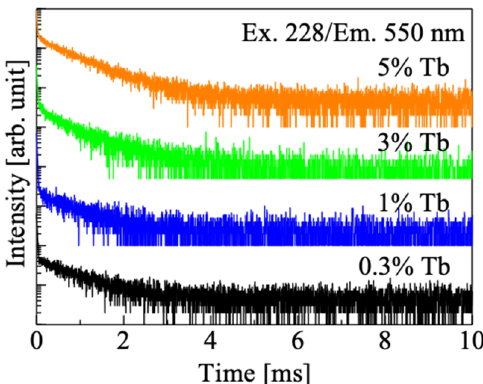
Figure 5. PL decay curves of Tb-doped MgGa 2 O 4 . Table 1. PL QY and decay time constants of the crystals.